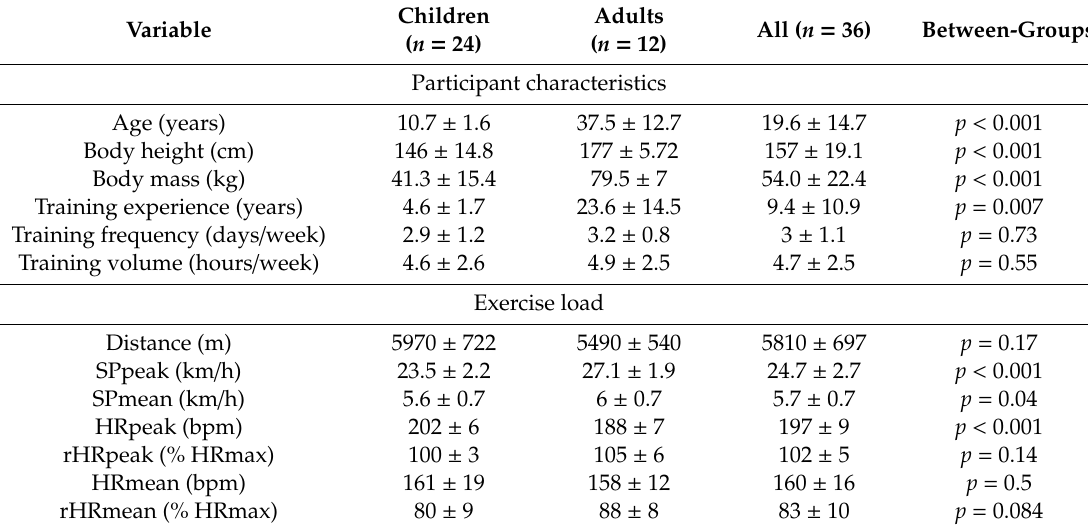
Table 1. Summary of participants’ characteristics and exercise load.